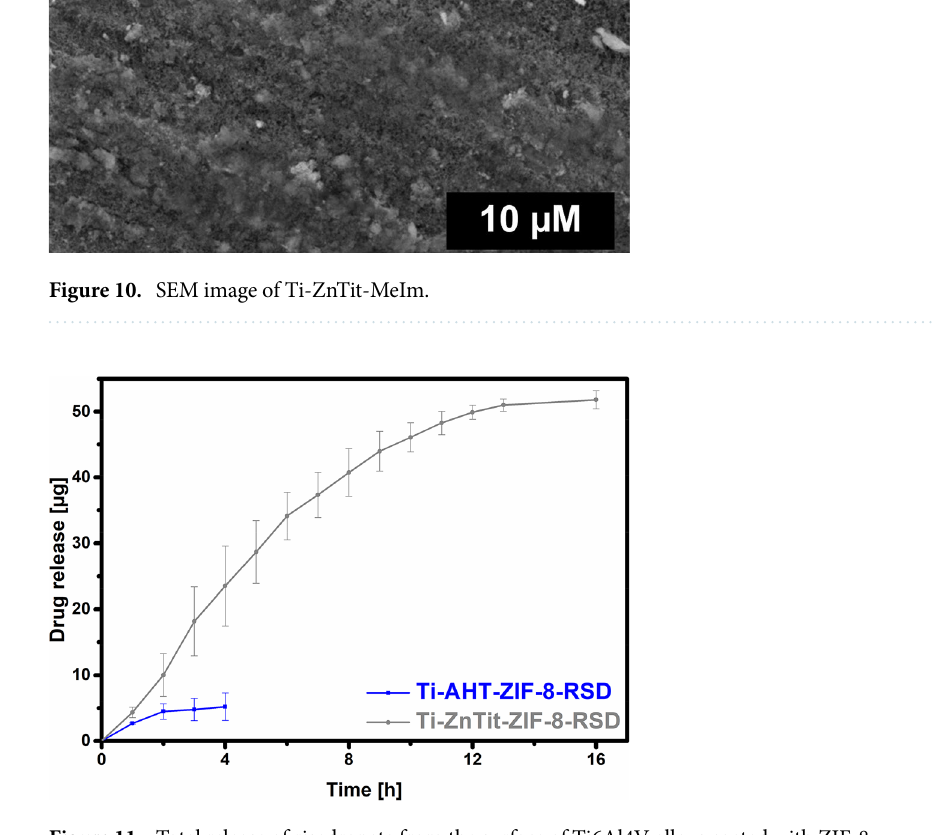
Figure 11. Total release of risedronate from the surface of Ti6Al4V alloys coated with